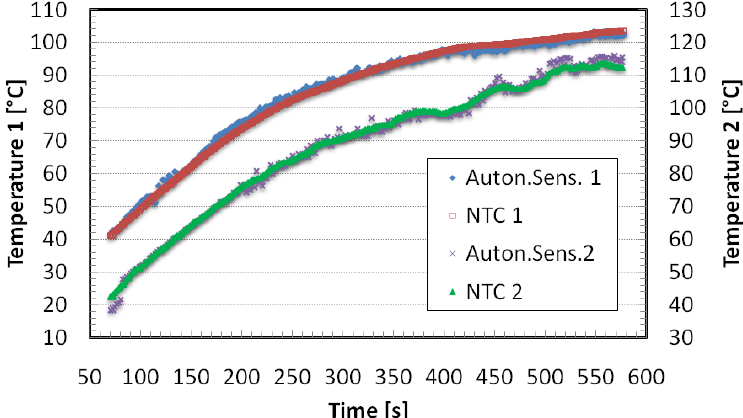
Figure 10. Autonomous sensors measured temperature and reference NTC measured temperature.